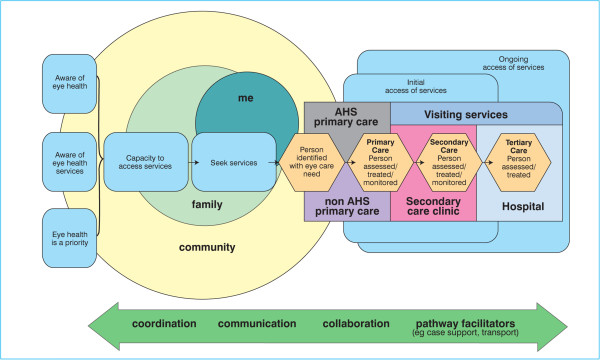
Patient care pathway [[1],[2]].